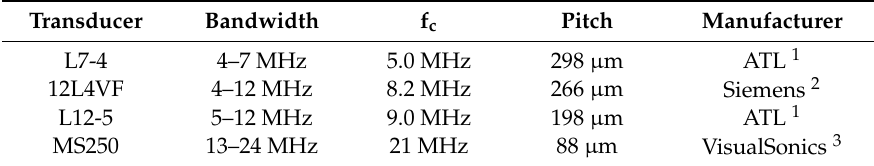
Figure 4. Experimental setup: transducer (Table 1) was connected to a Verasonics (V1 or Vantage) research ultrasound machine; element data were acquired prior to and after rotation ( θ Rot ) of a container in which a gelatin phantom was positioned (light grey) and water was poured on top of the phantom to ensure ultrasonic coupling. Table 1. Transducers used in this study with their bandwidth, central frequency (f c ), and pitch.